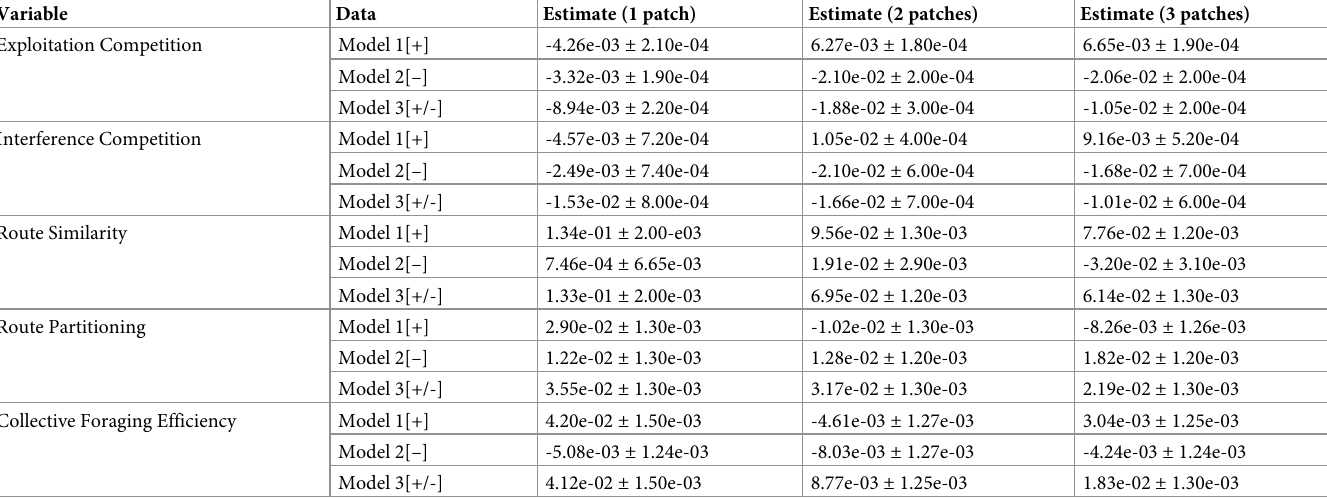
Table 2. Statistical output for simulations with two individuals. Comparisons of (i) exploitation competition, (ii) interference competition, (iii) route similarity, (iv) route partitioning and (v) collective foraging efficiency through GLMMs using bee identity as a random effect (bee identity nested in simulation identity for simulated data). The results presented are the slope estimate along with a 95% confidence interval of the mean, for each type of environment tested (See Methods for